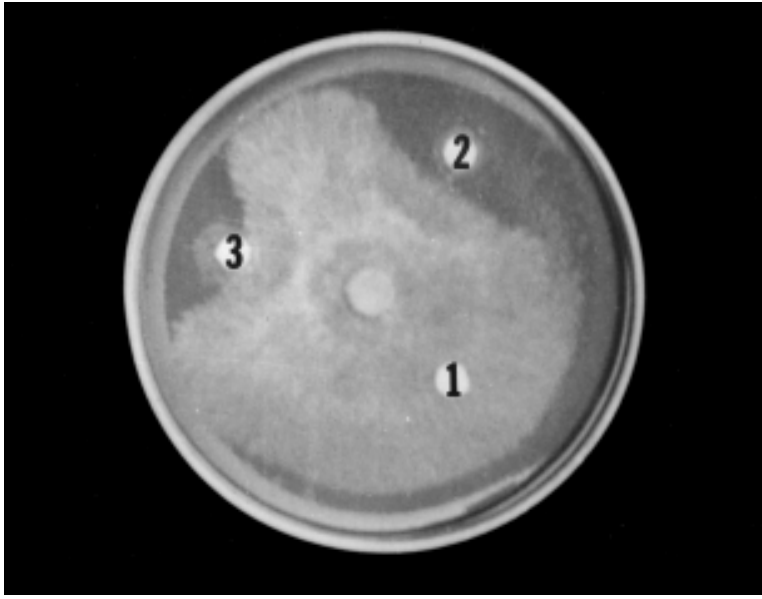
Fig. 3. Antifungal activity of purified rice chitinase against mycelium of Rhizoctonia solani. 1, buffer; 2, crude dialysed fraction; 3, purified